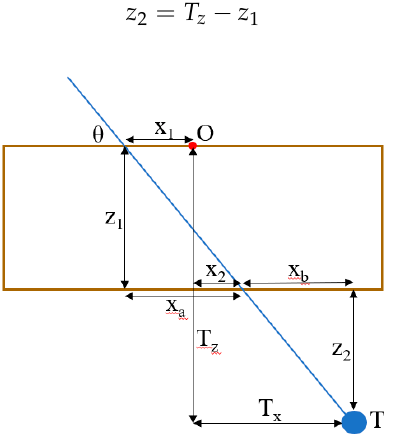
Figure 2. Schematic diagram of a needle insertion trajectory.